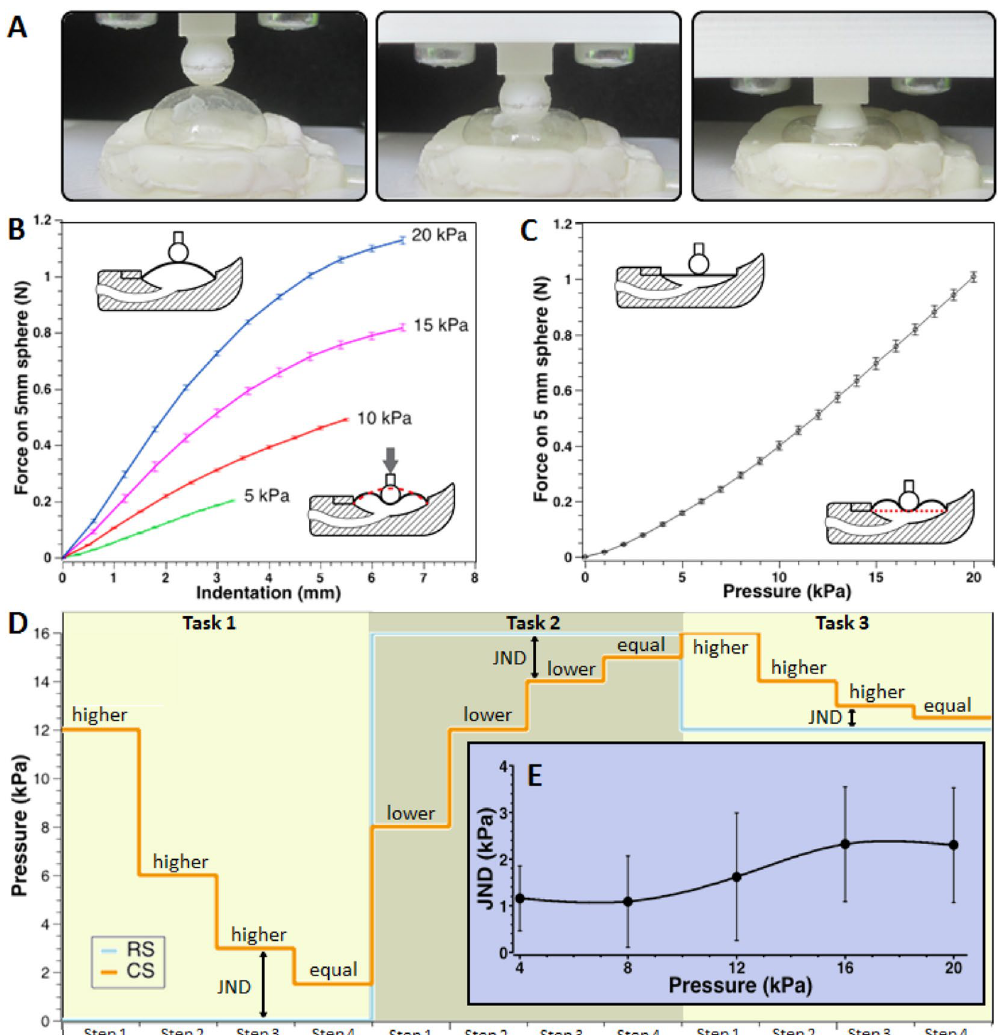
Figure 3. Indentation force, blocking force and psychophysical performance of the softness display. ( A ) Optical images of an indentation of the pressurised membrane with a spherical indenter having a diameter of 5 mm. ( B ) Static indentation force as a function of the indentation depth, for different driving pressures; the error bars represent the standard deviation among three samples, tested three times each. ( C ) Blocking force gathered by the same spherical indenter upon a sudden pressurisation of the membrane, as a function of the driving pressure; the error bars represent the standard deviation among three samples, tested three times each. ( D ) Example of three consecutive perceptual tasks during a psychophysical test; if a comparison stimulus (CS) is perceived as higher/lower than the reference stimulus (RS), the subsequent CS is decreased/increased until the two stimuli are perceived as equal; that final condition provides the Just Noticeable Difference (JND) related to RS. ( E ) JND as a function of the driving pressure; the error bars represent the standard deviation among ten